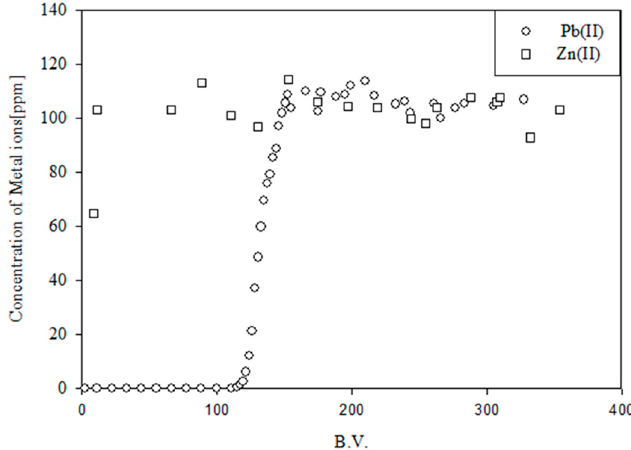
Figure 9. Pb(II) and Zn(II) breakthrough profiles when a solution containing 100 mg/L Pb(II) and 110 mg/L Zn(II) at pH 2.01 was passed through a column packed with crosslinked pectic acid gel. The flow rate was 6.5 mL/h [9]. (With permission for reuse from Elsevier B.V.).